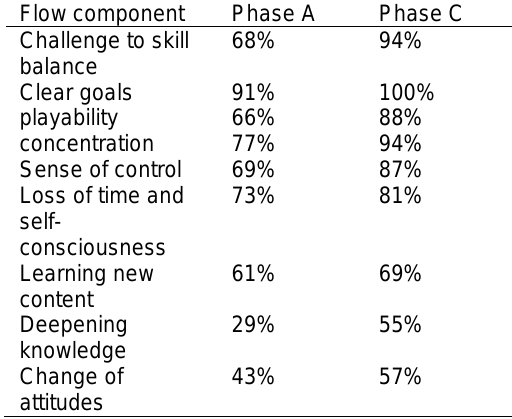
Figure 2. Distribution of students’ “success” in the game “Couch Potatoes